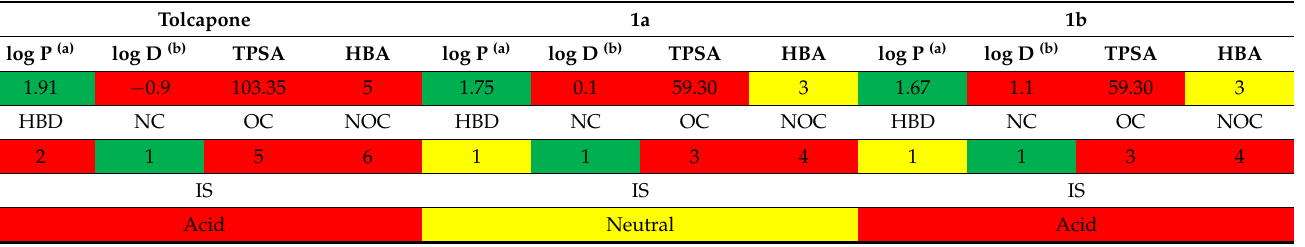
Table 4. Colour-coded descriptors linked to BBB permeation. Green indicates descriptors favourable for BBB permeation, yellow indicates borderline descriptors and red indicates descriptors having negative influence on permeation. All parameters are calculated using SwissADME